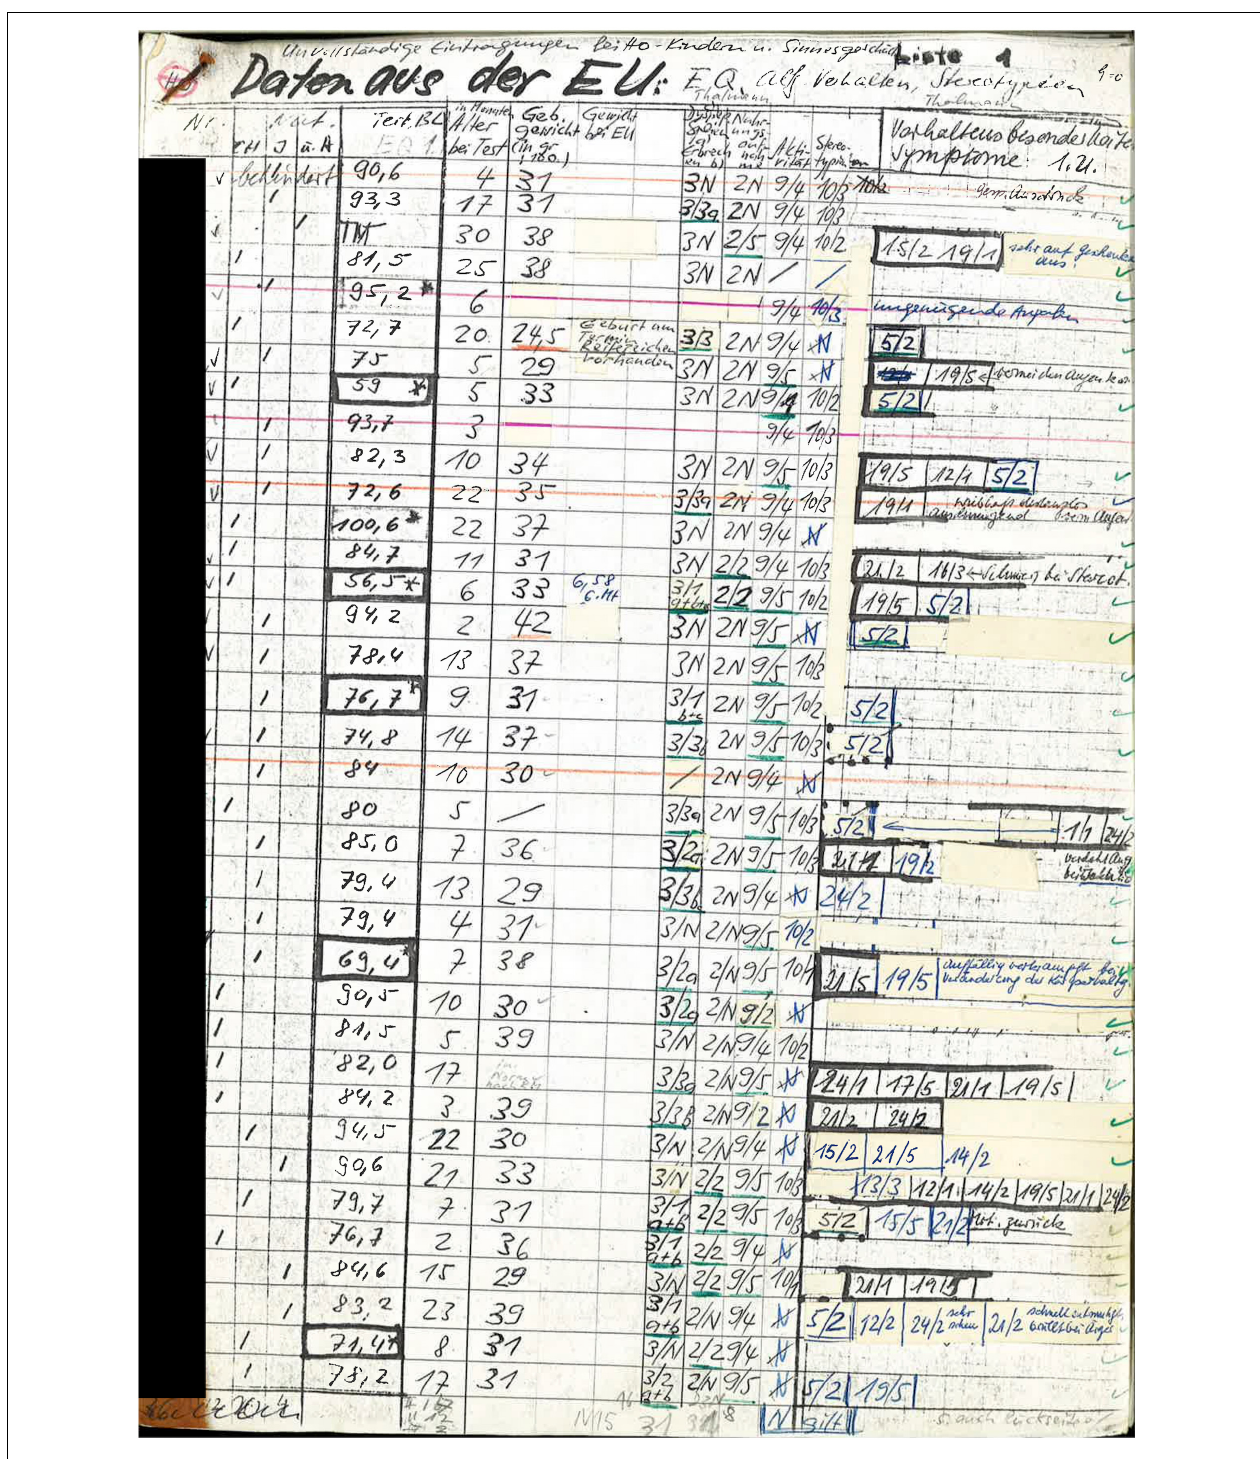
FIGURE 3 | Example of person-centered data (Wave 1).